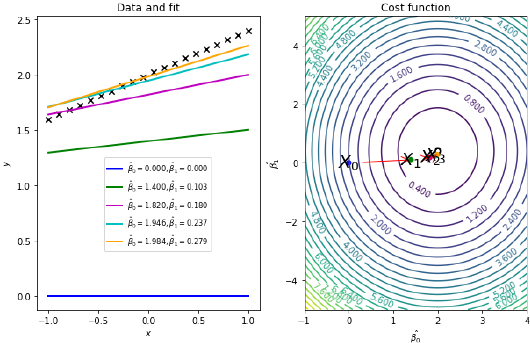
Figure 2. Demonstration of gradient